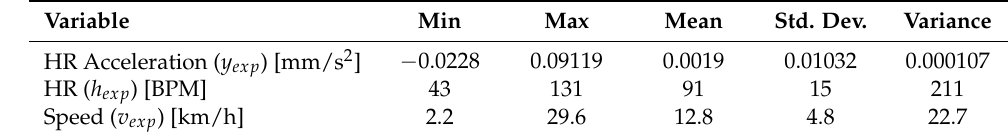
Table 5. Descriptive statistics of the experimental